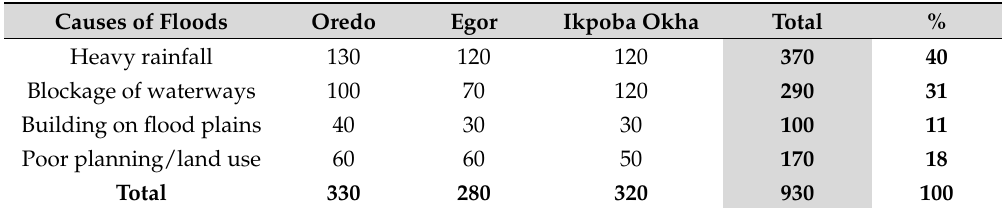
Table 2. Causes of floods in Benin